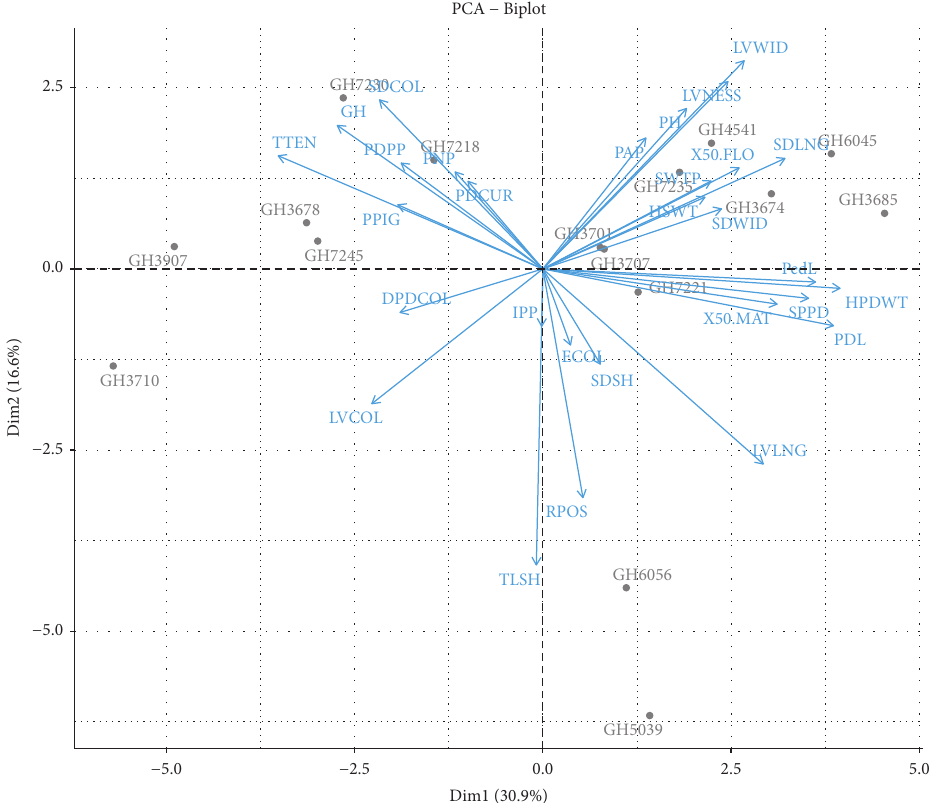
Figure 2: Biplot showing the association among agromorphological traits and genotypes. LVNESS � number of leaves, LVWID � leaf width, PAP � pod attachment to peduncle, PH � plant height, SWTP � seed weight per plant, HSWT � hundred seed weight, SDLNG � seed length, SDWID � seed width, PedL � peduncle length, HPDWT � hundred pod weight, PDL � pod length, SPPD � seeds per pod, LVLNG � leaf length, SDSH � seed shape, TLSH � terminal leaf shape, PNP � pod number per plant, PDPP � pods per peduncle, GH � growth habit, TTEN � twining tendency, PPIG � plant pigmentation, PDCUR � pod curvature, IPP- immature pod pigmentation, DPDCOL � dry pod colour, LVCOL � leaf colour, X50.MAT � days to 50% maturity, X50.FLO � days to 50% flowering, RPOS � raceme position, SDCOL � seed colour, and ECOL � seed eye